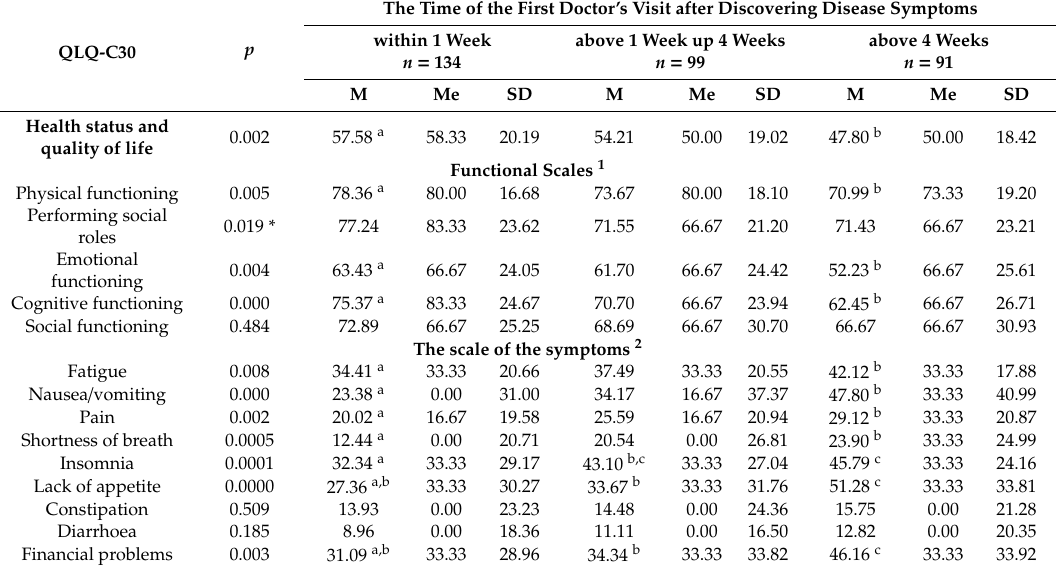
Table 5. Assessment of women’s quality of life—categories related to QLQ-C30 and the time of the first doctor’s visit after discovering disease